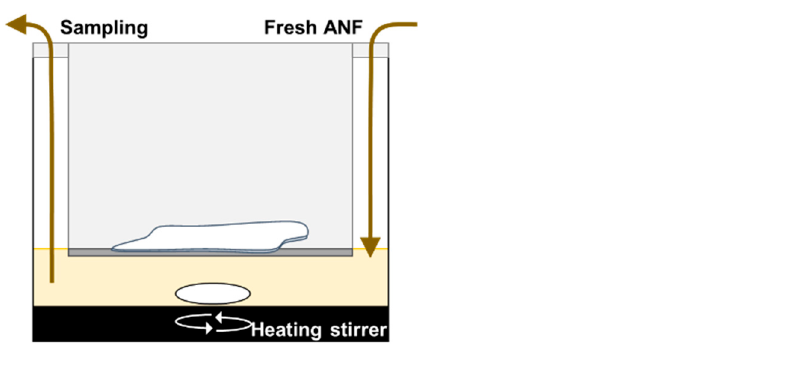
Figure 1. Schematic representation of an in vitro evaluation system for drug dissolution in nasal mucus in the intranasal environment. Artificial nasal fluid (ANF, derived from 4% mucin in PBS; pH6.4; 0.7 mL) was used to mimic nasal mucus, and maintained at 30 °C using a heating stirrer. Film (20 mm square) was applied onto the surface of ANF. ANF samples (10 μ L) were taken, and fresh ANF was added after sampling at the appropriate intervals. Table 2. Morphological differences in rats and humans for nasal cavity and mucus.